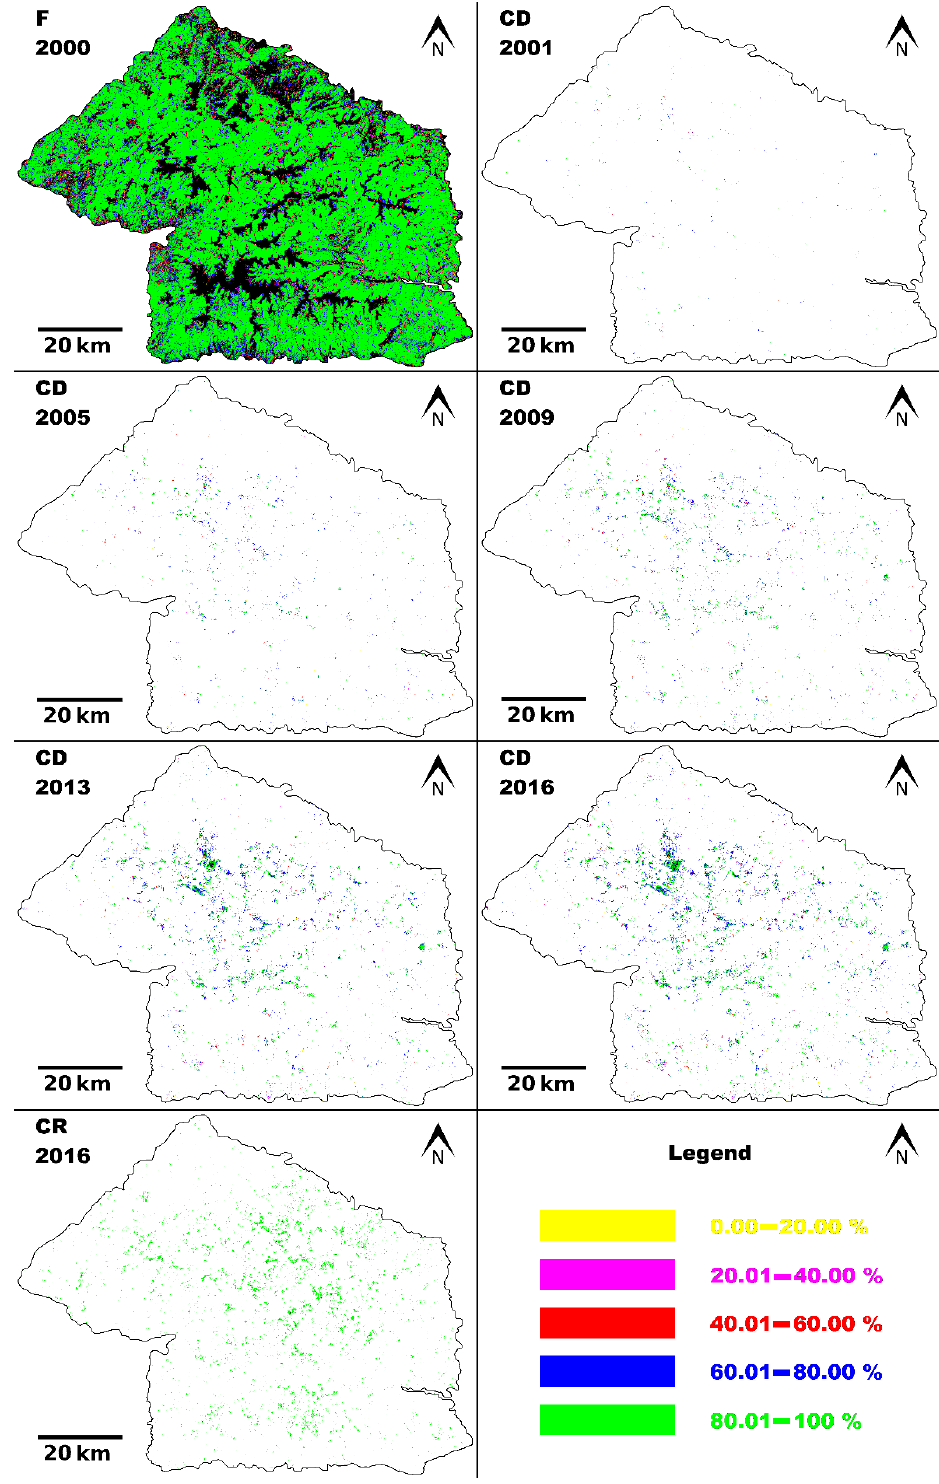
Figure 3. Spatial distribution of forests (F), cumulative loss (CD) and cumulative gain areas (CR), and differences between cumulative loss and cumulative gain areas (CD–CR) taking into account the degree of forest coverage per analyzed pixel.